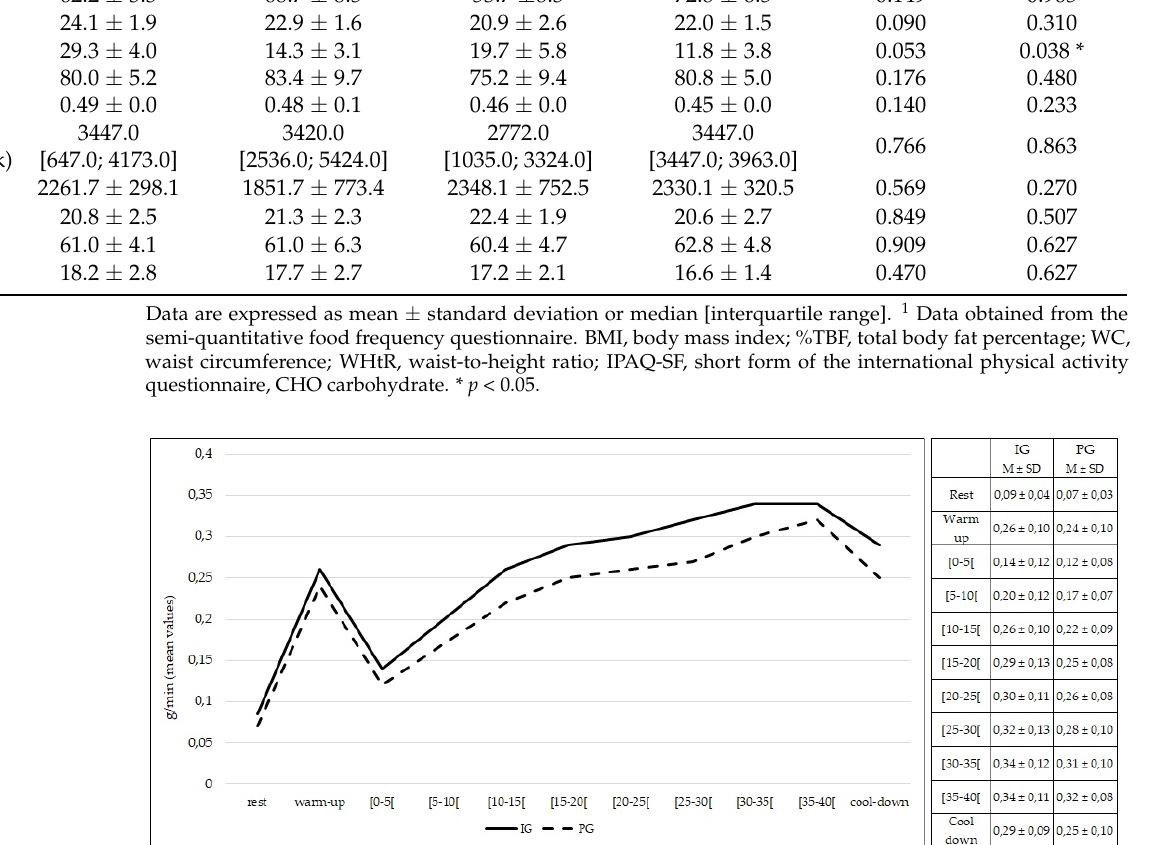
found at rest and during exercise ( p > 0.05) in the rate of lipid oxidation (Figure 5). The same findings were observed comparing males from both groups ( p > 0.05) (Figure 6).